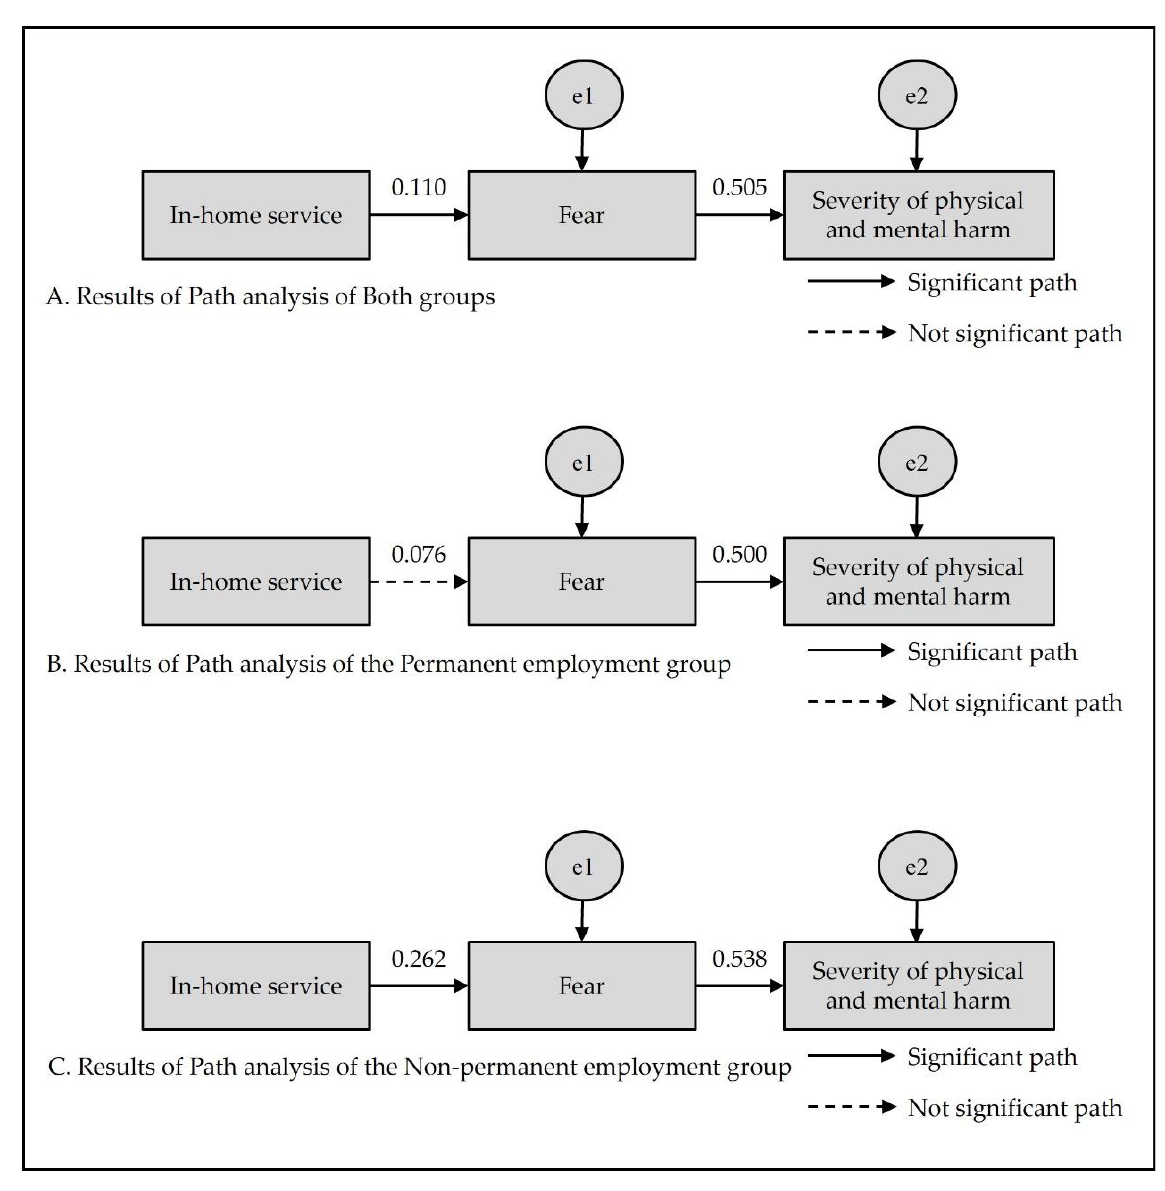
Figure 2. Results of path analysis.